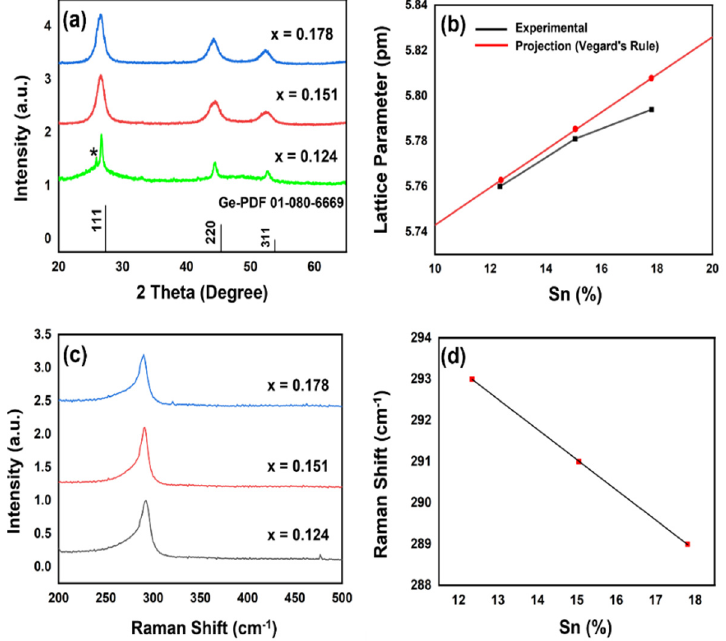
Figure 1. ( a ) Powder XRD patterns of Ge 1-x Sn x nanoparticles. ( b ) A plot illustrating the lattice pa- rameters based on XRD patterns (Black) and projection of theoretical lattice parameters calculated using Vegard’s law (Red). *GeO 2 impurity peak. ( c ) Raman spectra of the Ge 1-x Sn x nanoparticles. ( d ) A plot illustrating the systematic red-shifting of the Ge–Ge optical phonon mode with increasing Sn composition.